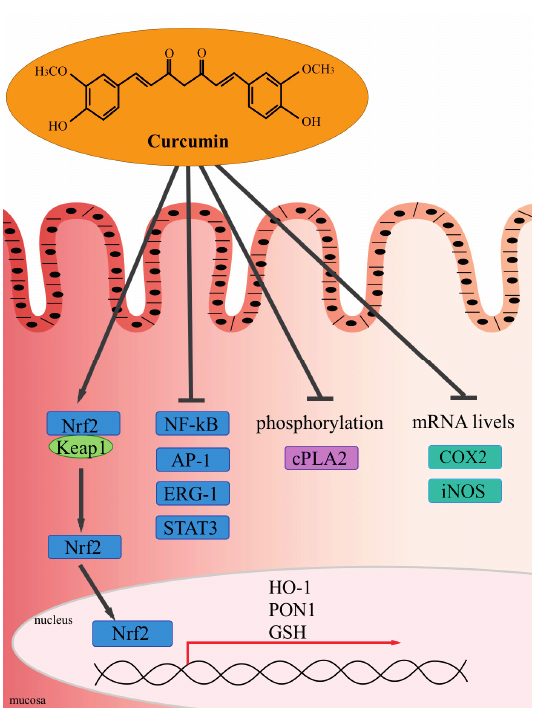
Figure 1. The curcumin activity in